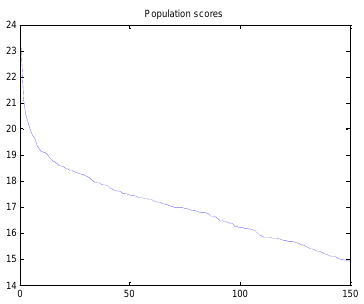
Figure 7. Population cumulative fitness during the evolution The differential evolution has a drawback, namely the continuously mutated genes can be modified in a way that they start resembling each other; in critical case the population converges into one single position. To avoid that negative feature, the training is monitored by the variances of the genes. If there are enough variations within the population, the variances of the coordinates are high. Resembling can be detected by dramatical decrease in the variance diagram. A healthy variance plot can be seen in Fig. 8.